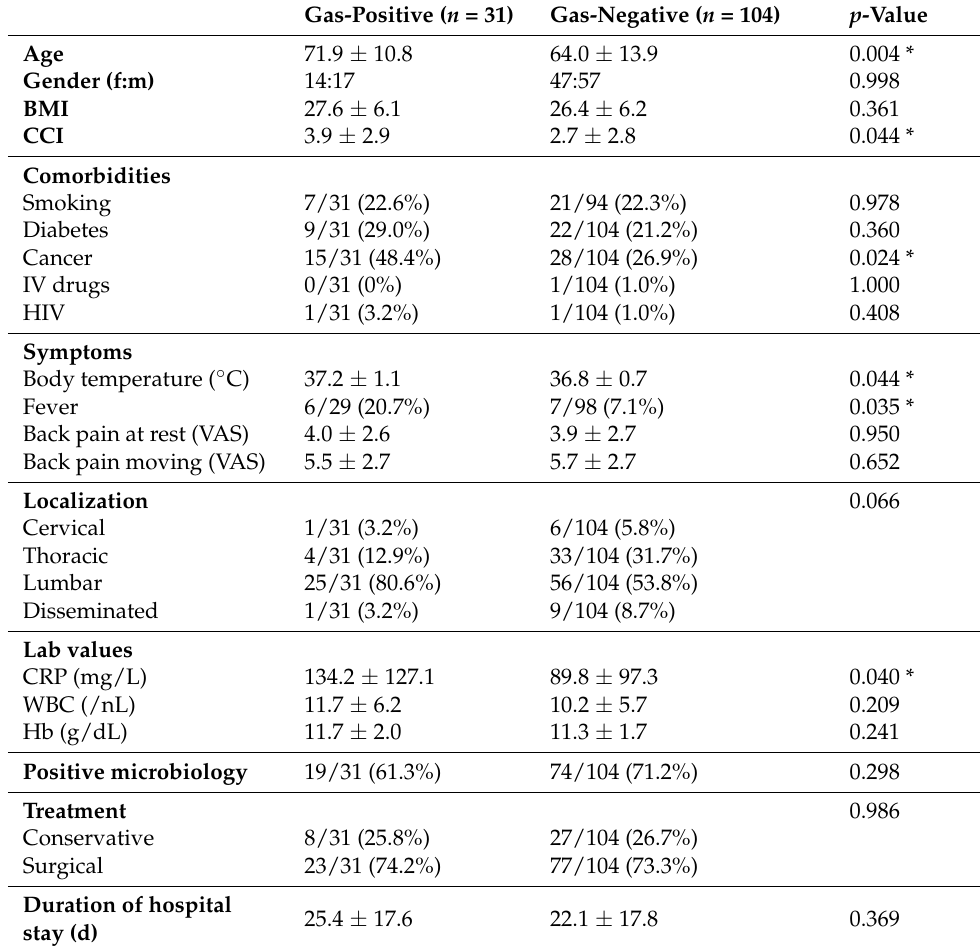
Table 2. Patient characteristics of gas-positive and gas-negative patient groups. * indicates statistically significant results. BMI, body mass index; CCI, Charlson Comorbidity Index; IV, intravenous; HIV, human immunodeficiency virus; VAS, visual analog scale; CRP, C-reactive protein; WBC, white blood cell count; Hb,